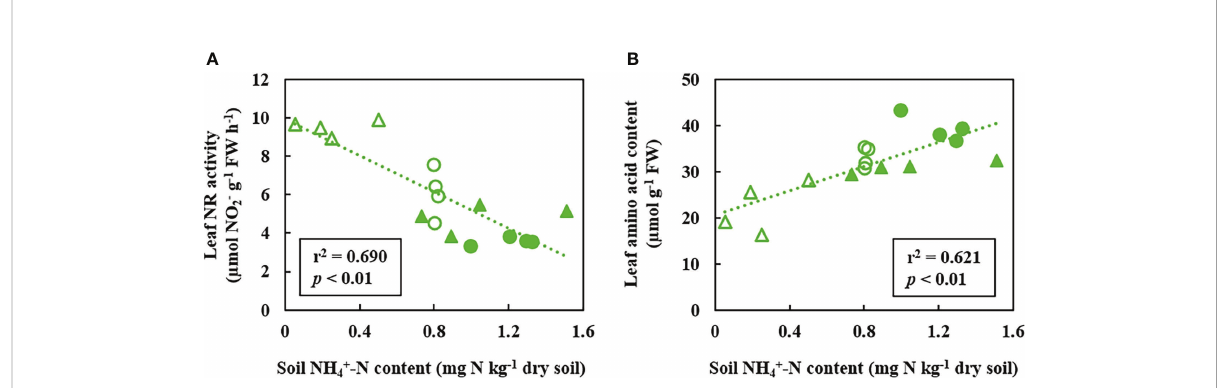
FIGURE 3 Correlation analysis between leaf NR activity (A) and leaf amino acid content (B) versus soil NH + 4 − N content 30 days after fertilization with ammonium sulphate (AS). Empty circles correspond to ROELFS BNI isogenic-lines lacking BNI-trait (Control), full circles correspond to ROELFS BNI-isogenic-lines with BNI-trait (BNI), empty triangles correspond to MUNAL BNI-isogenic-lines lacking BNI-trait (Control), full triangles correspond to MUNAL BNI-isogenic-lines with BNI-trait